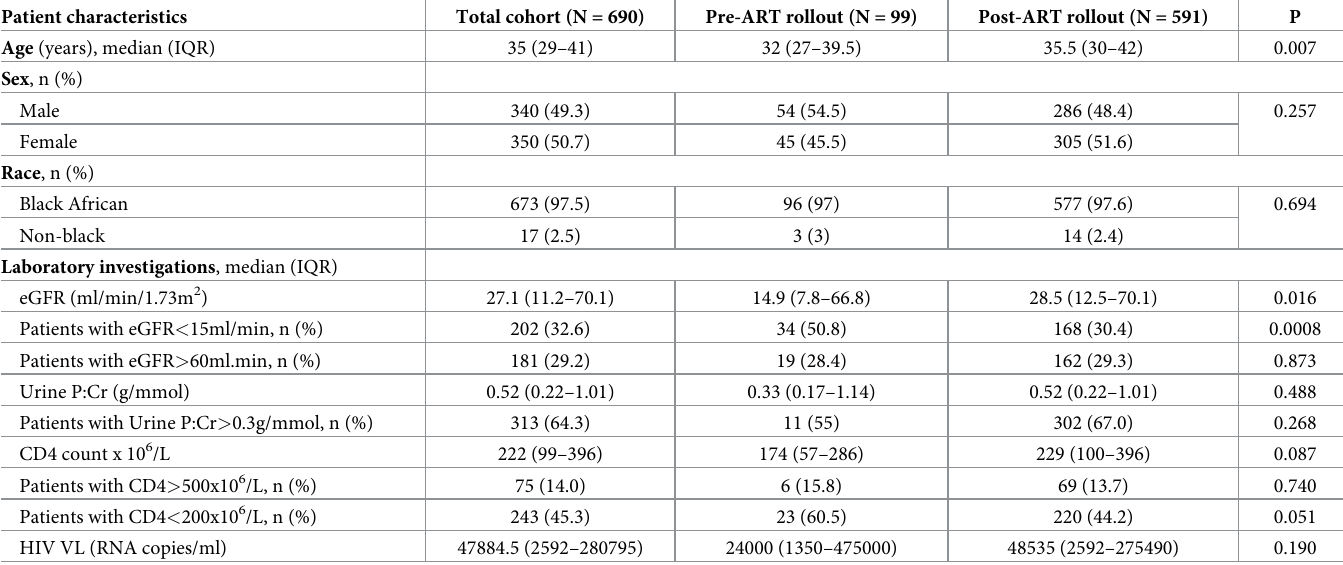
Table 1. Characteristics of HIV-positive patients who underwent kidney biopsy. Patient